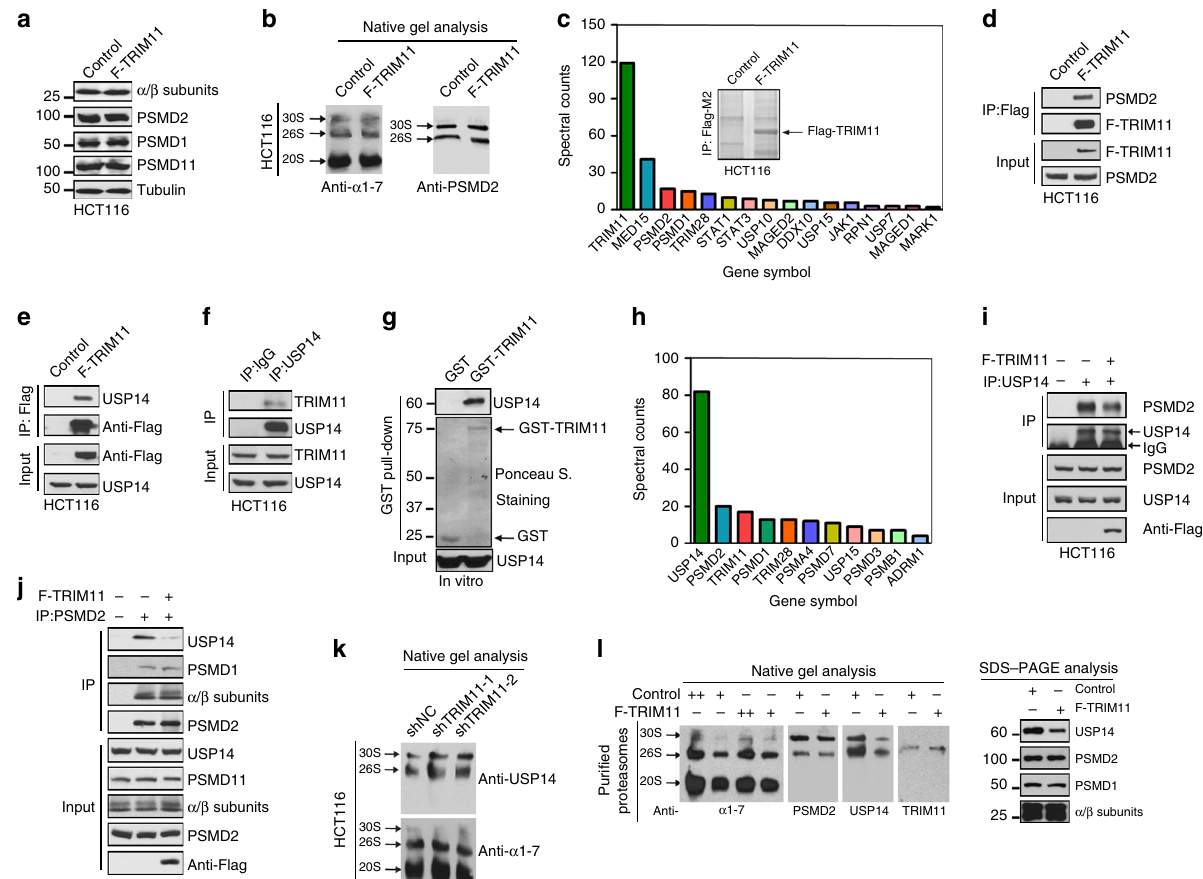
Fig. 4 TRIM11 binds to both PSMD2 and USP14 and inhibits their interaction. a Control and Flag-TRIM11-expressing HCT116 cells were analyzed by western blot with the indicated antibodies. b Lysate fractions enriched in proteasomes (pellets of 5 h, 100,000× g centrifugation) from control and Flag-TRIM11- expressing HCT116 cells were analyzed by native gel and immunoblotted with antibody against the 20 S subunit α 1-7 (left) or the 19 S subunit PSMD2 (right). c , h Control, Flag-TRIM11-expressing ( c ), and Flag-USP14-expressing ( h ) HCT116 cell lysates were incubated with beads conjugated with anti-Flag antibodies. Immunoprecipitates (IPs) were analyzed by mass spectrometry. Shown are spectral counts of peptides derived from the indicated proteins relative to those in the control IPs ( c , h ) and Coomassie blue staining of IPs ( c , inset). d Interaction of Flag-TRIM11 and endogenous PSMD2 in HCT116 cells analyzed by co-immunoprecipitation (co-IP) assay. e , f Interaction of Flag-TRIM11 ( e ) and endogenous TRIM11 ( f ) with endogenous USP14 in HCT116 cells. g Interaction of USP14 with TRIM11 was analyzed by an in vitro pull-down assay using puri fi ed GST or GST-TRIM11 immobilized on beads (1 μ g) and Flag- USP14 (2 μ g). i , j Interaction of endogenous USP14 and PSMD2 in control and TRIM11-overexpressing cells was analyzed by co-IP assays using anti-USP14 ( i ) or anti-PSMD2 ( j ) antibody. k Cell Lysate fractions enriched with the proteasomes were isolated from control and TRIM11 knockdown HCT116 cells and analyzed by native gel electrophoresis and immunoblotting using α 1-7 and USP14 antibodies. l Proteasomes puri fi ed from control and TRIM11- overexpressing HCT116 cells ( ++ , 1 μ g; + , 0.5 μ g) were analyzed by native (left) and SDS (right) PAGE, followed by western blot with the indicated antibodies. Uncropped blots are presented in Supplementary Fig.